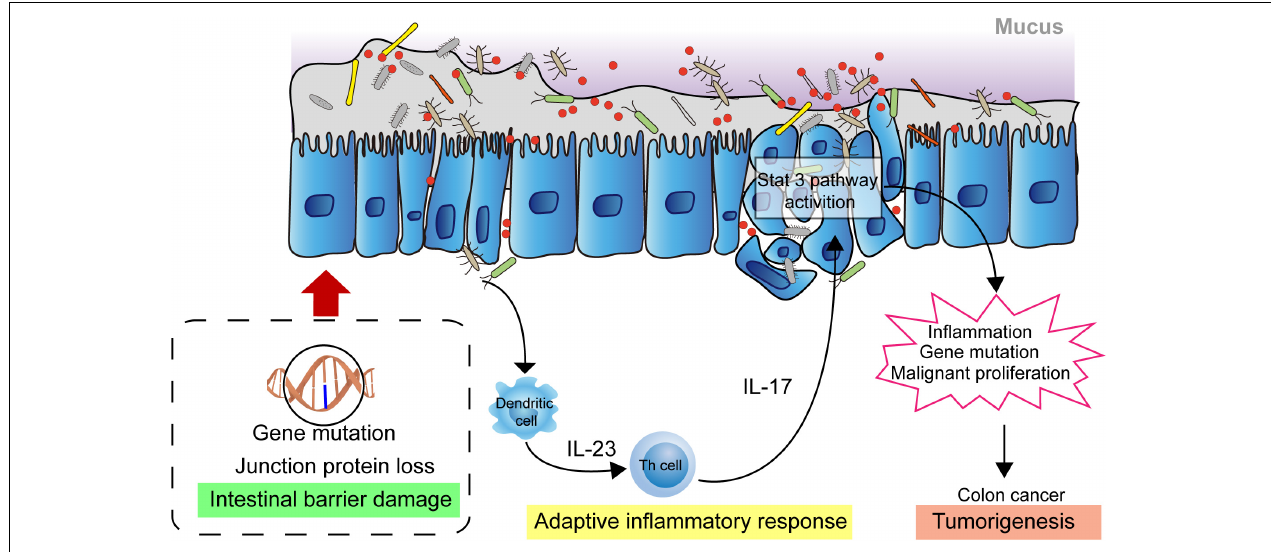
FIGURE 1 | Intestinal microbial facilitating colon cancer progression. The damaged intestinal mucosal barrier permits the transposition of intestinal bacteria and metabolites from the lumen to the lamina propria which activates adaptive immune response. The releasing cytokines drives development of Th17 cells response. The response activates the STAT3, NF- κ B signaling pathway in epithelial cells, promoting cell proliferation and invasion, leading to further destruction of mucosal integrity and increased inflammatory response. These biological events contribute to the development of colon cancer.